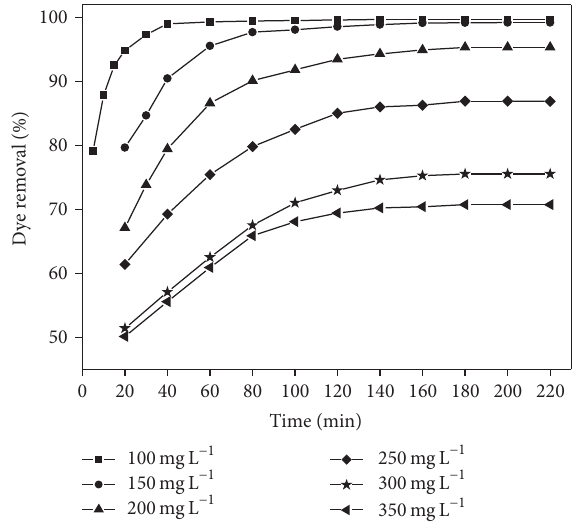
F 1: Effect of contact time and initial dye concentration on MB adsorption (concentration of adsorbent = 1gL